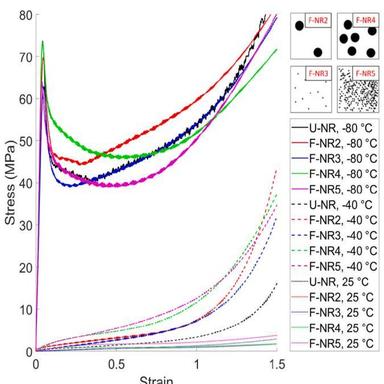
Highlighting selected low rate, varying temperature data for all NR grades.